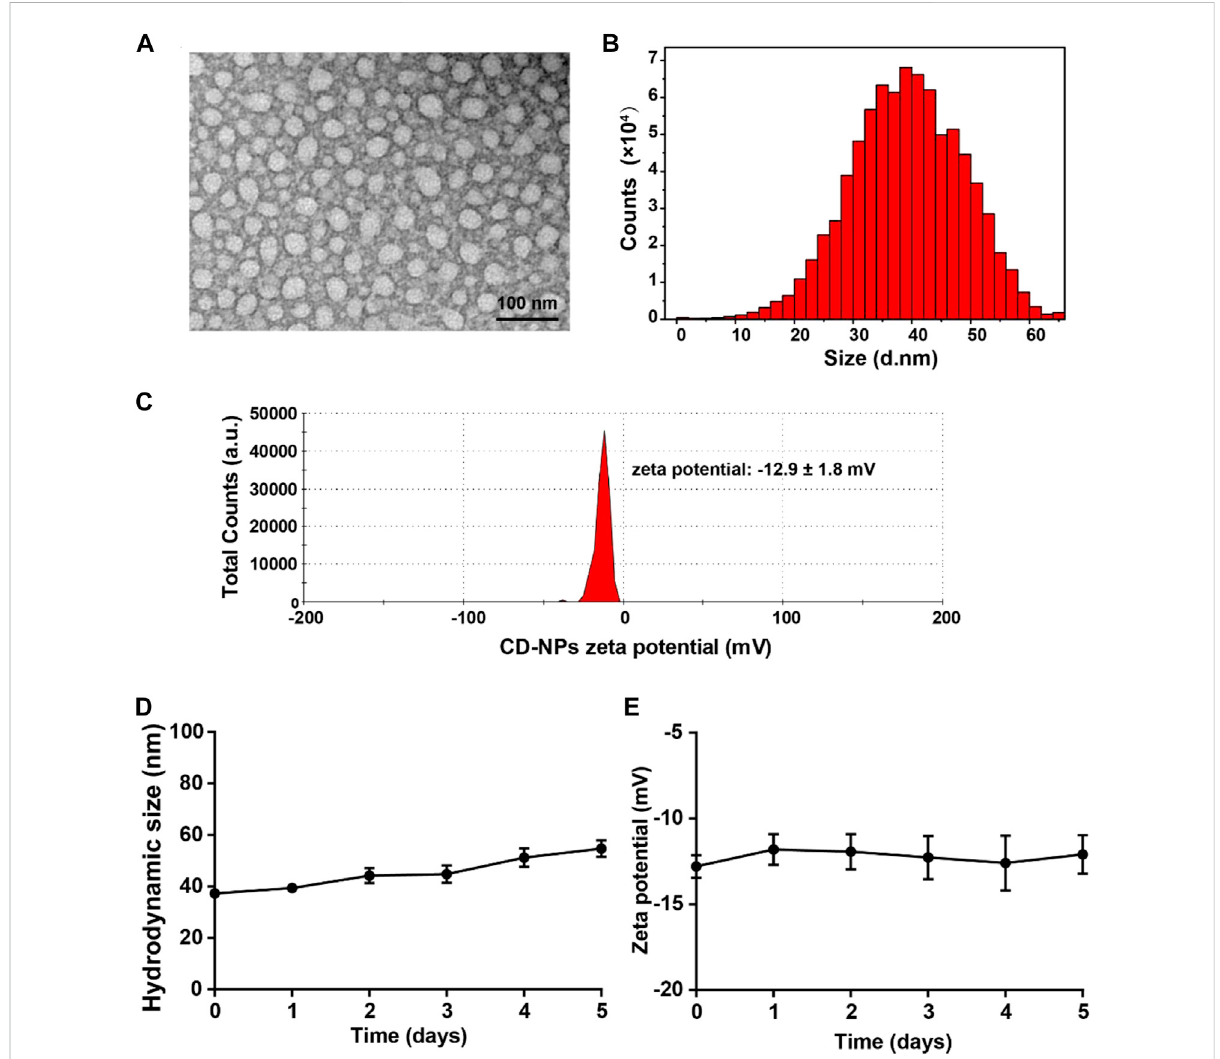
Characterizationofthepeptideself-assemblednanomedicine. (A) TEMimagesofpreparedCD-NPs. (B) Hydrodynamicsizedistributionand (C) zeta potential of CD-NPs in PBS measured by DLS. (D) Changes in hydrodynamic size and (E) zeta potential of CD-NPs incubated in PBS for 5